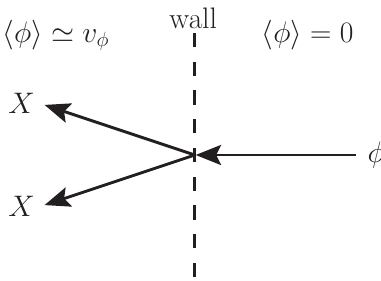
Figure 1: When light φ quanta enter the bubble of new phase, they can produce X + X DM pairs, which are highly boosted in the original plasma